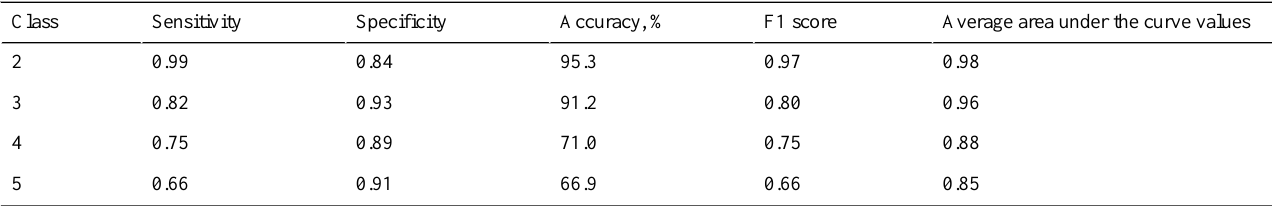
Table 2. Performance of the artificial intelligence model for classifying voice disorders under different classification